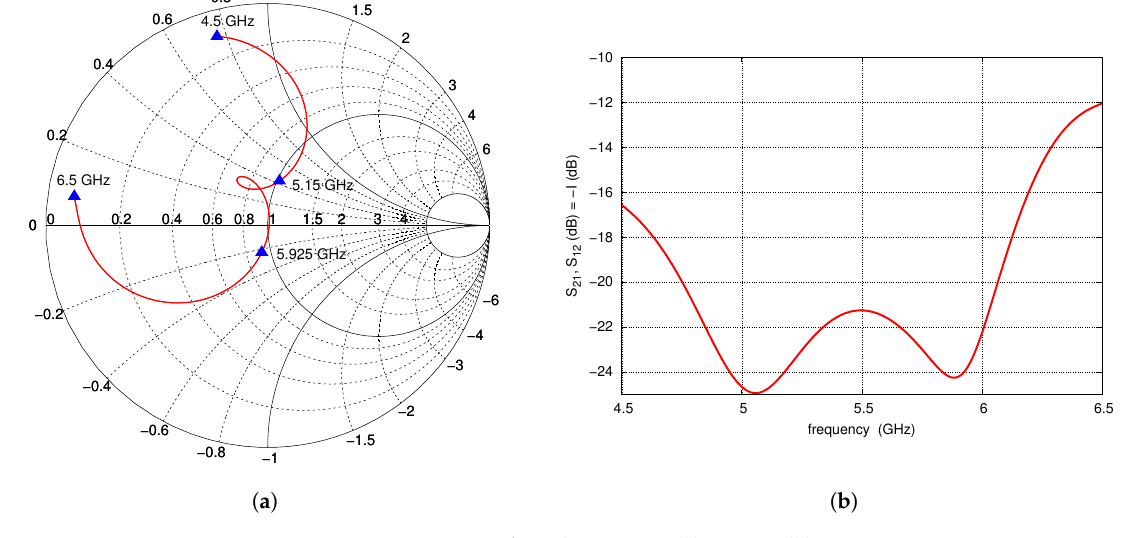
Figure 2. S-parameters of single ECMSA: ( a ) s 11 , s 22 , ( b ) s 21